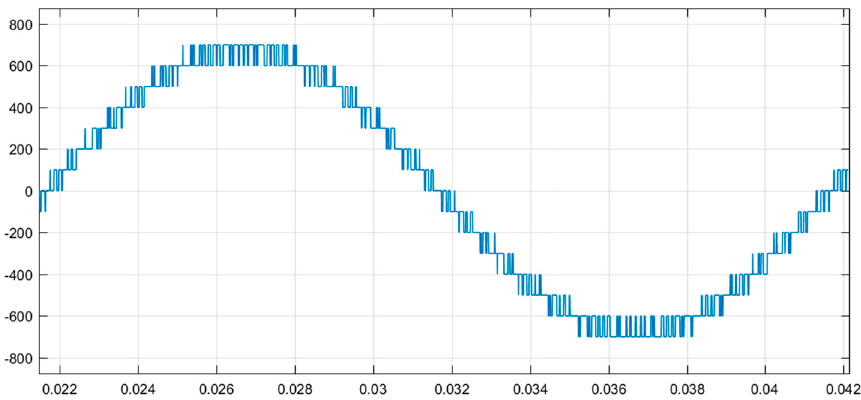
Figure 13. Three-phase four H-bridge CHB inverter line voltage for LS PWM and equal sources.